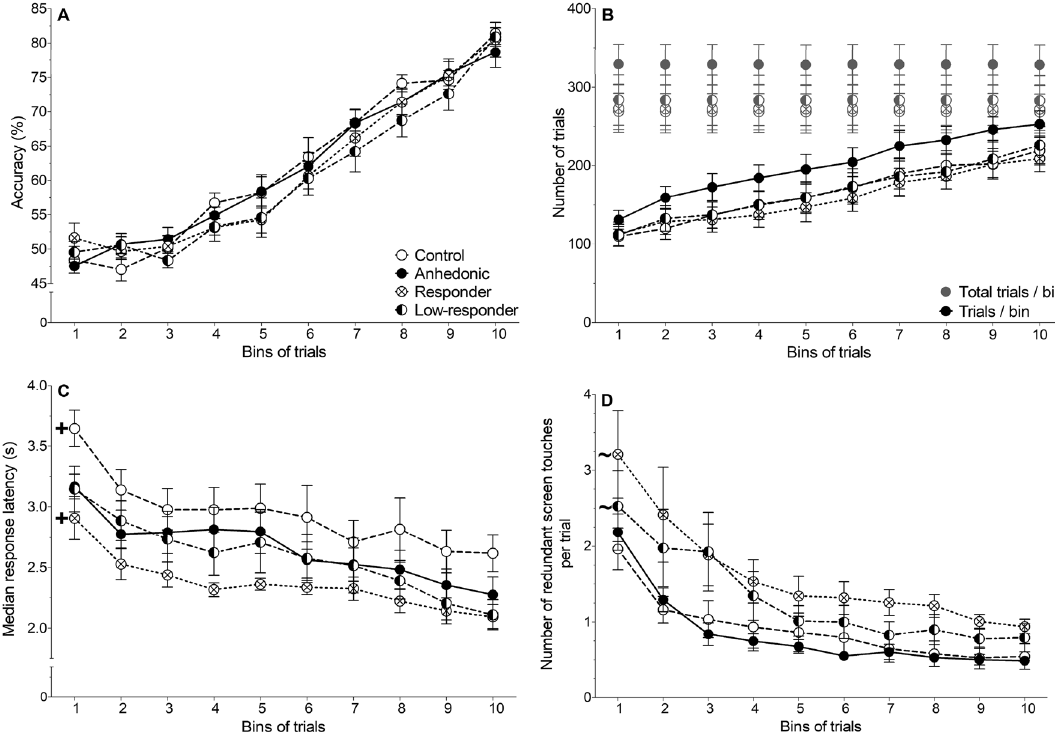
Figure 4. Behavioural parameters during dPAL task acquisition of all animals. ( A ) Accuracy; percent of correct choices. ( B ) Number of trials (black) and number of total trials (trials plus correction trials, grey). ( C ) Median response latency. ( D ) Number of additional, i.e. redundant screen touches per trial (trial or correction trial). Group means (± SEM) are shown with ‘ + ’ indicating a significant difference of the respective group to the three other groups and ‘ ~ ’ indicating a significant difference to controls and anhedonic-like rats (Bonferroni post-hoc comparisons; n = 10 for all